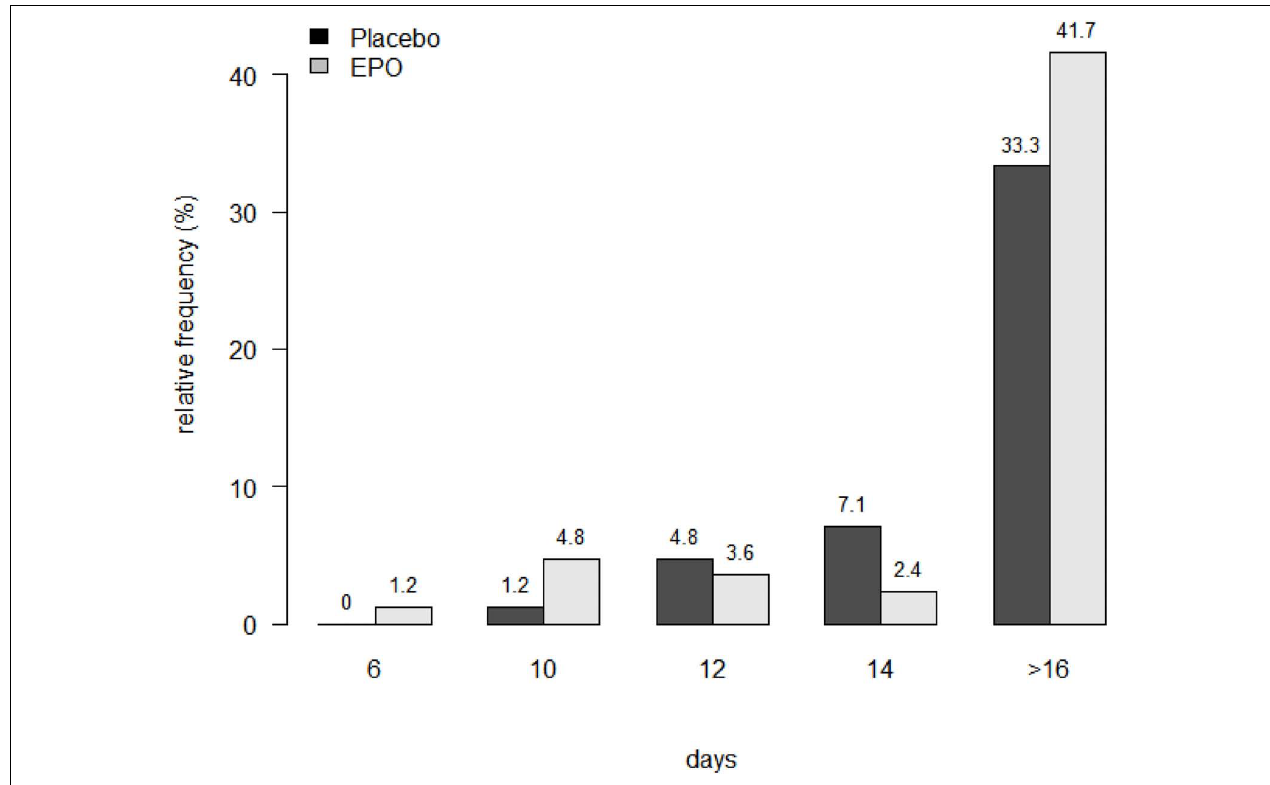
FIGURE 3 | Detailed Analysis of Re-epithelialization of Study Site at Days: 6, 10, 12, 14 and 16. Legend: ITT population data are presented in % of patients with a complete healed study site at the respective days. Remark the high number of not healed study sites at D 16.